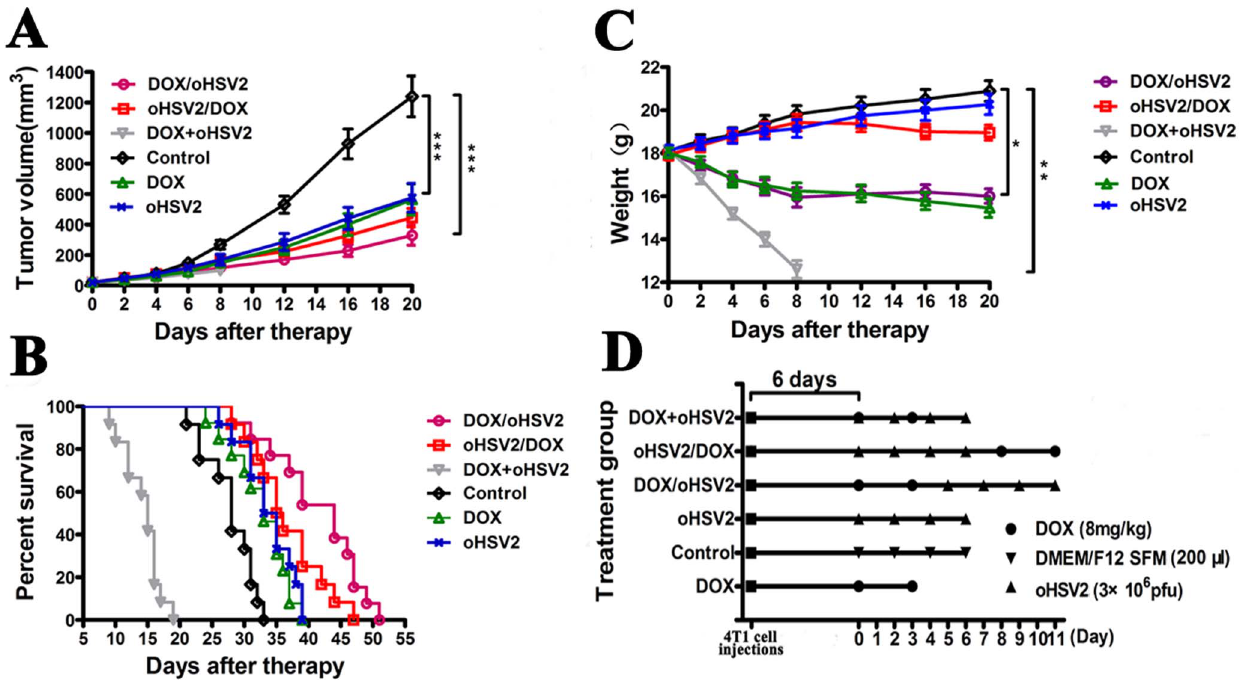
Figure 7 . Anticancer effect of DOX coupled with oHSV2 in different treatment combinations in 4T1 breast tumors. Mice bearing 4T1 tumors were treated as described in the Materials and Methods section. And the Control, oHSV2 and DOX groups were the same in Fig 6 and 7. A ) The tumor volume of mice was measured every 4 days following treatments. The data are presented as the mean 6 SEM (n=12). B ) The median survival times for the 3 groups are illustrated in Kaplan–Meier survival curves (n=12). Median survival: DOX/oHSV2, 44 days, p , 0.001; oHSV2/DOX, 35 days, p , 0.001; and DOX + oHSV2, 15 days. C ) The weight of mice was measured every 4 days following treatments. The data are presented as the mean 6 SEM (n=12), *, p , 0.05; **, p , 0.01; and ***, p , 0.001. D) Schematic of the experimental design. Each spot represents one